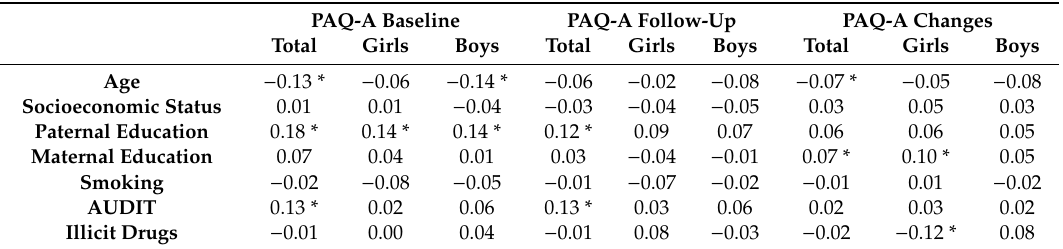
Table 1. Spearman’s rank order correlations between sociodemographic variables and variables of substance use and misuse with physical activity as measured by Physical Activity Questionnaire for Adolescents (PAQ-A) in the studied adolescents.